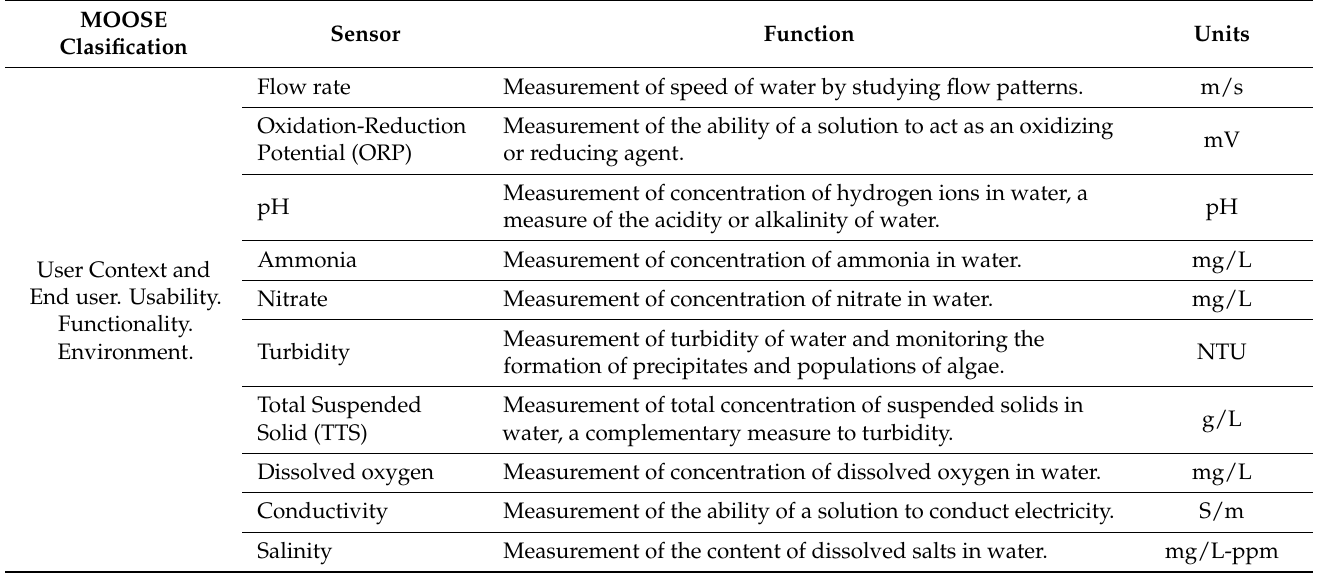
Table 3. Proposal of sensors for the obtained